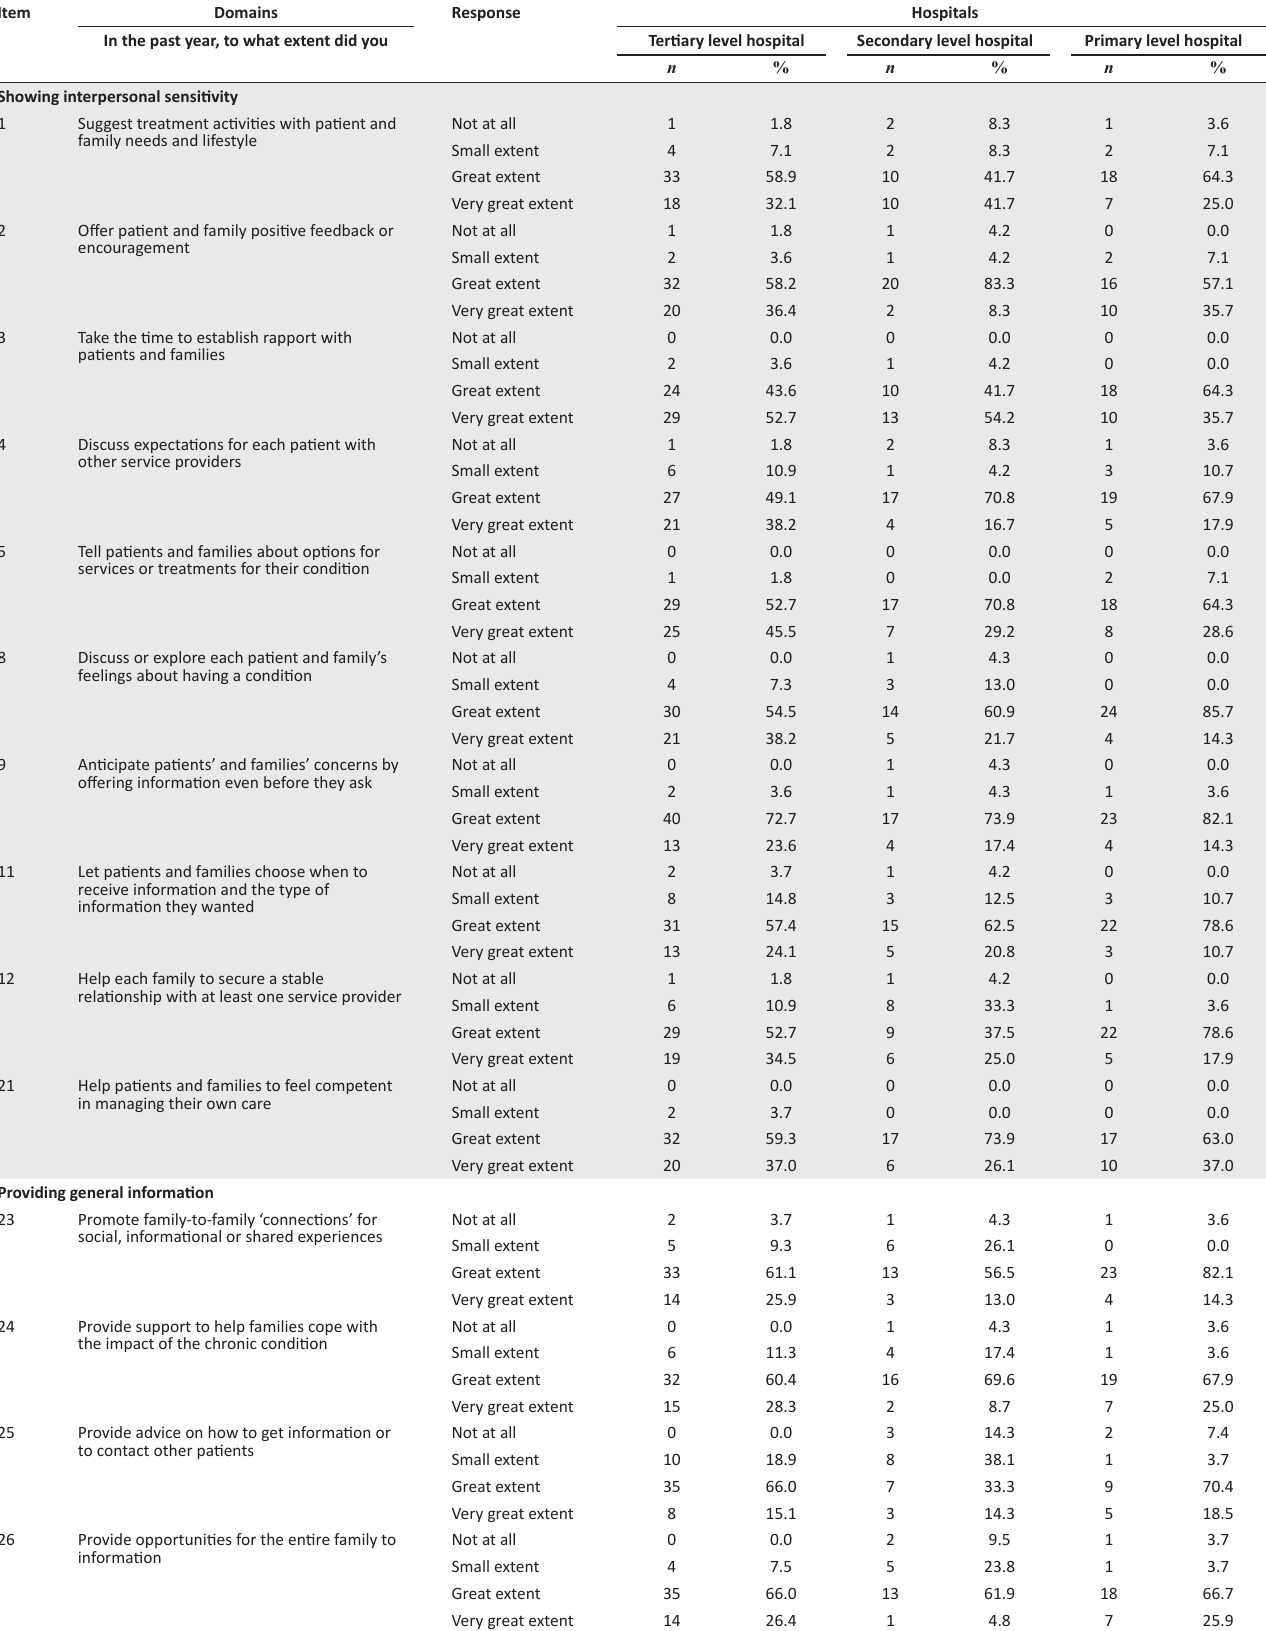
TABLE 1-A1: Patient and family centredness of